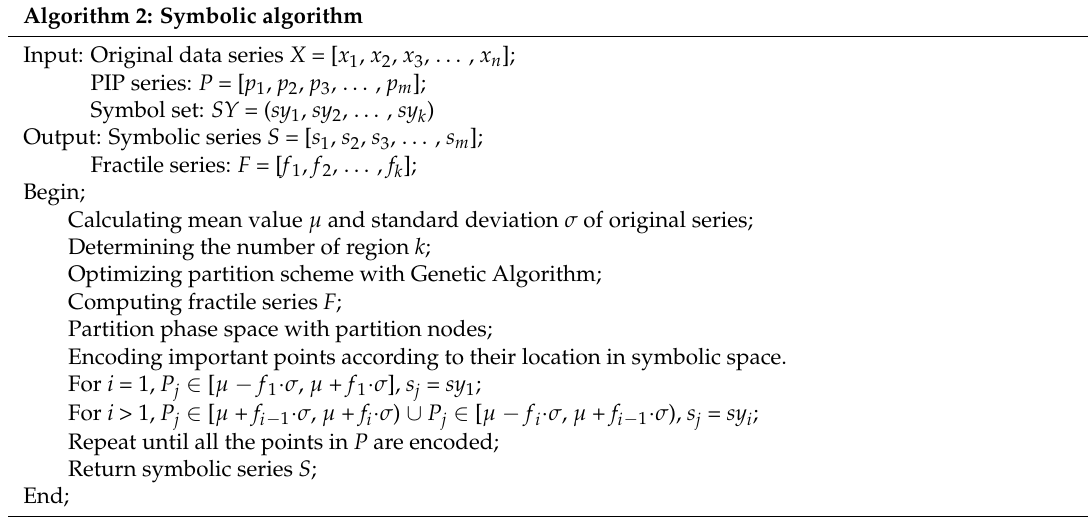
Table 2. Symbolization algorithm.